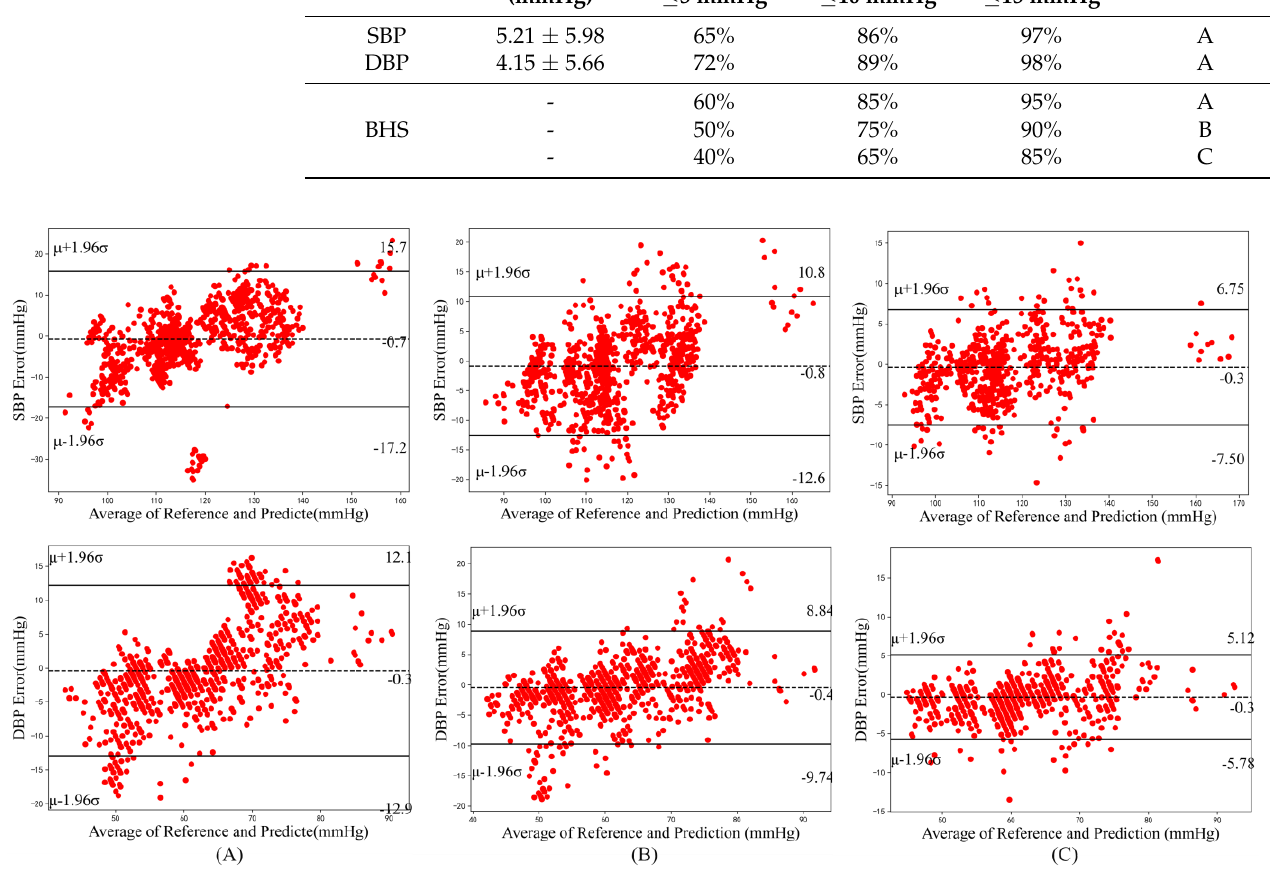
Figure 7. Bland–Altman plots showing the mean difference and 95% limits of agreement for SBP and DBP. The dotted line represents the mean value and the solid line represents the mean value ± 1.96 standard deviation. (( A ) all features; ( B ) after feature selection; ( C ) after calculation).